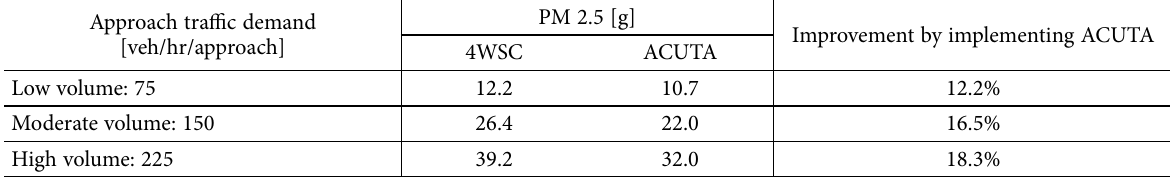
Table 8. Comparison of energy consumption between single-tile ACUTA and four-way stop control Approach traffic demand [veh/hr/approach]